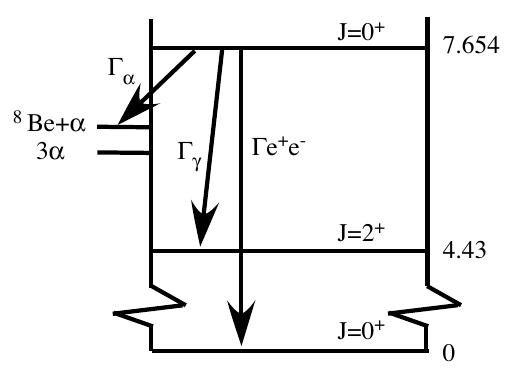
Figure 8.18: The structure of 12 C assumed by Figure 13: The part of the energy schemes of the 12 C Salpeter in 1957.  is the probability of decay nucleus relevant to the 3 α reactions as was finally as- ↵ sumed by Salpeter in his final paper in 1957 emitting an ↵ particle,  is the probability of  decay emitting a  photon and  is the prob- e ± The structure of 12 C as assumed by Salpeter in ability to decay by emitting an electron positron pair. This is after Salpeter obtained the improved results of Cook et al. 1957.